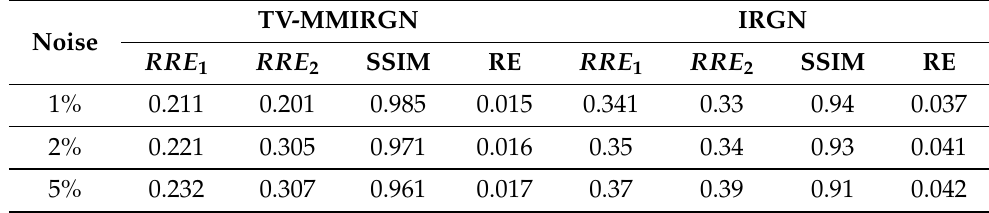
Figure 1. Example 1. ( a ) True conductivity distribution. ( b – d ) solution by TV-MMIRGN; ( e – g ) reconstructions with IRGN at the noise levels 1%, 2%, and 5% from left to right, respectively. Table 1. Figures of merit for Example